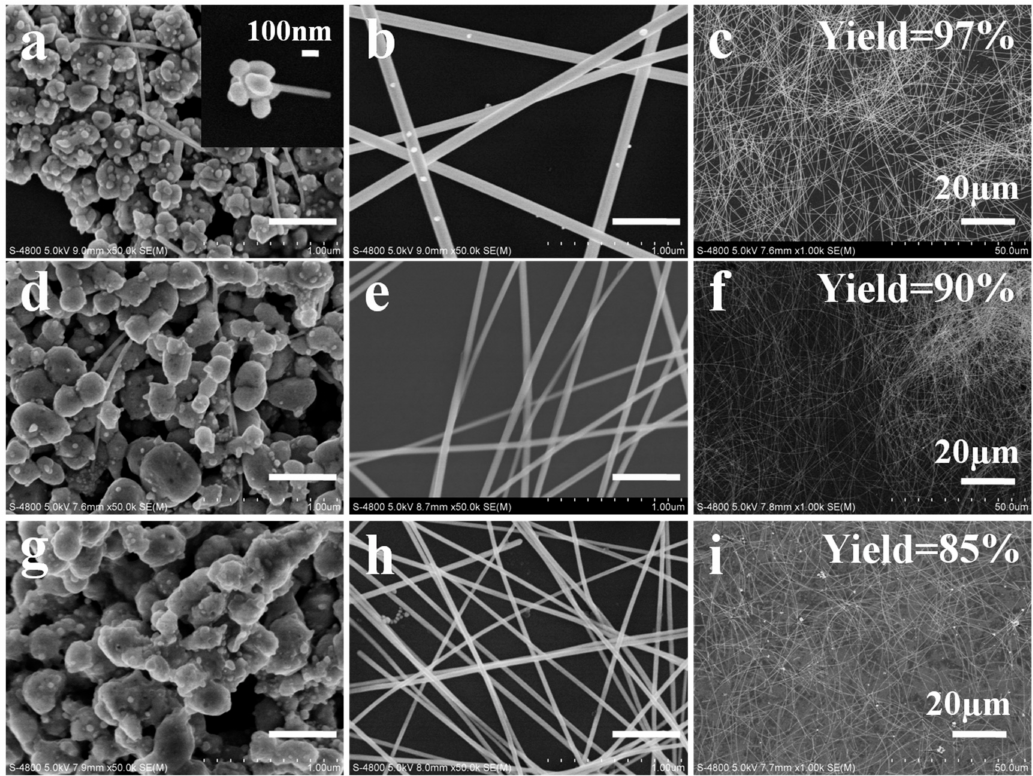
Figure 6. SEM images of AgNWs obtained with NaCl/NaBr co-additive of different concentration of 0.12/0.06 ( a – c ), 1.2/0.6 ( d – f ) and 6.0/3.0 mM ( g – i ) at growth times of 10 (left column) and 30 min (middle column), respectively. The scale bar is 500 nm. Low magnification SEM images of AgNWs at 30 min growth time are shown in the right